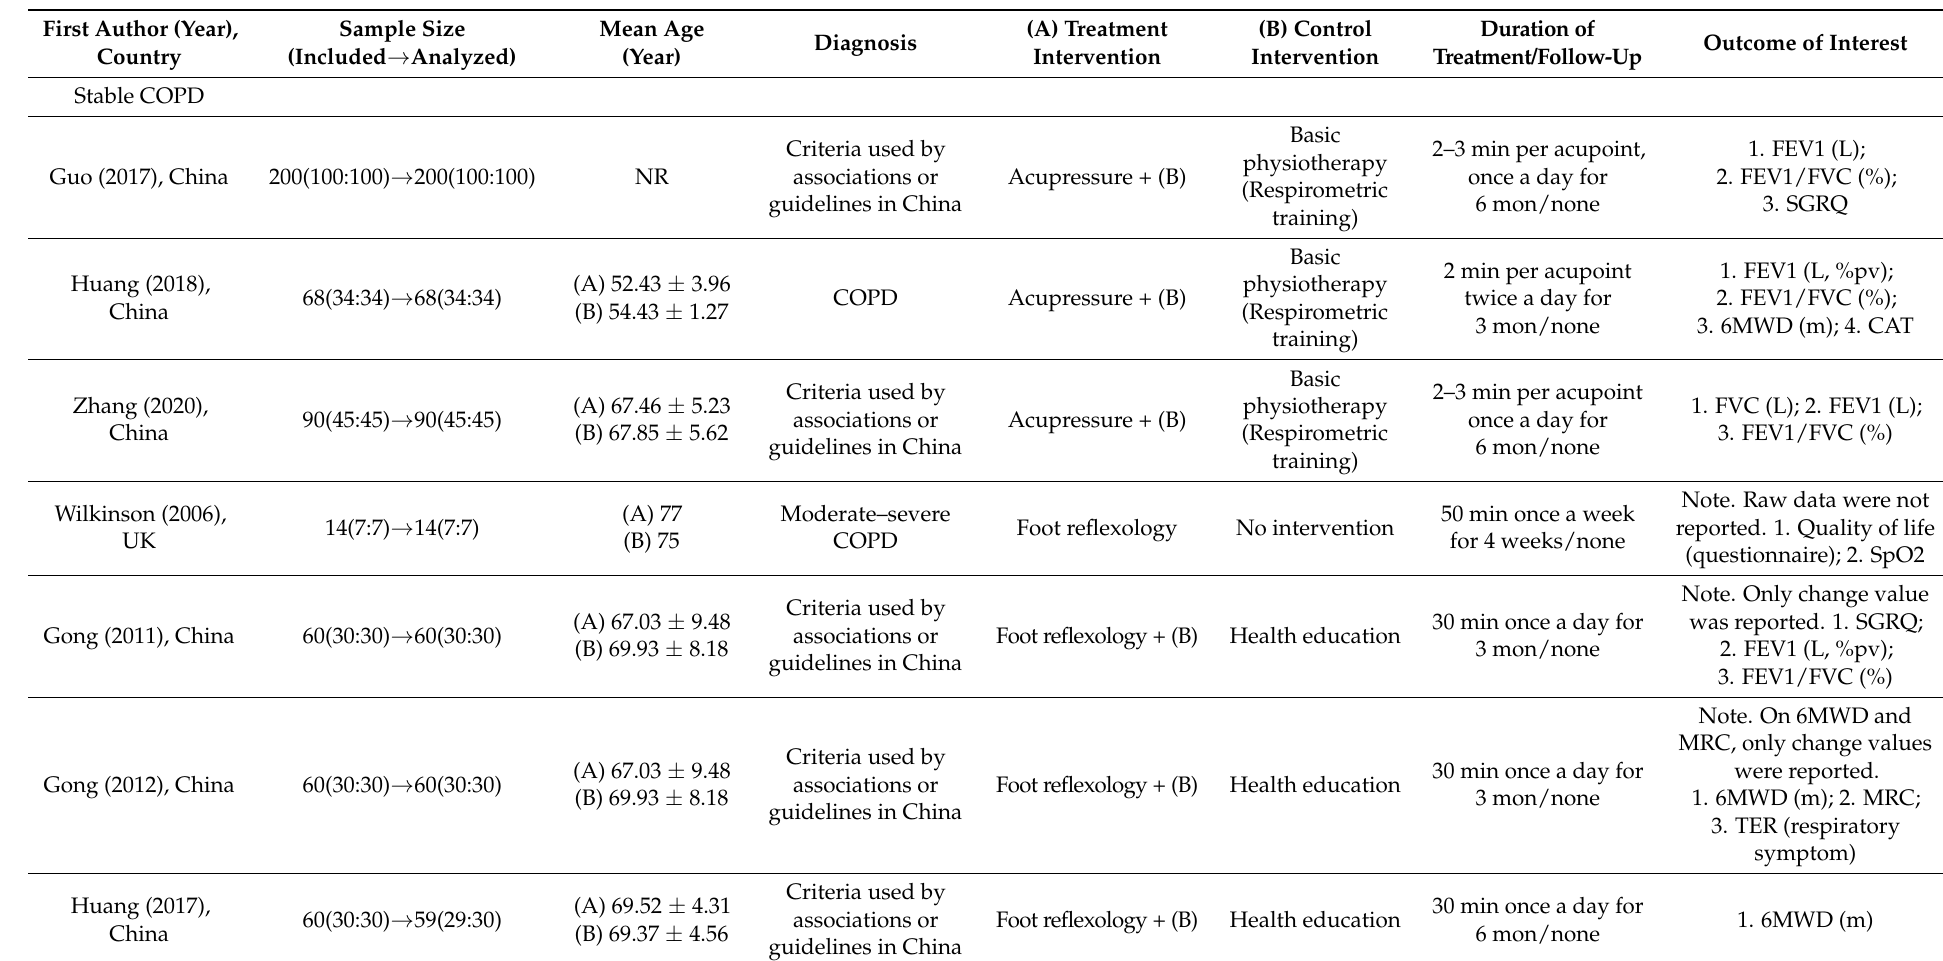
Table 2. Characteristics of included studies using Eastern manual